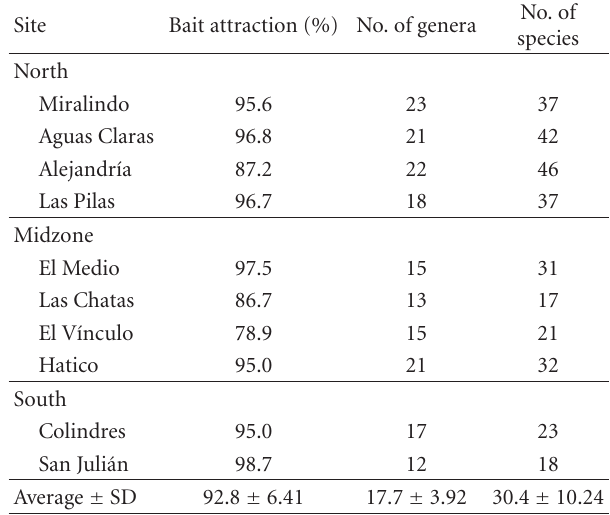
Table 2: E ff ectiveness of tuna-fish baits and total richness of ant genera and species in the study